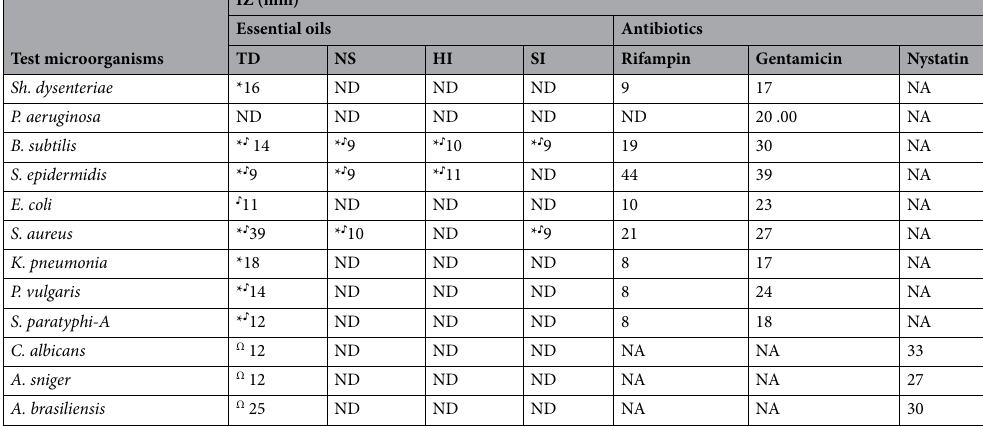
Table 2. Inhibition-zone diameters provided by antibiotics (used as references) and the essential oils from Thymus daenensis (TD), Nepeta sessilifolia (NS), Hymenocrater incanus (HI), and Stachys inflata (SI) . Mean values ± standard deviations of three cultures were reported. NA no activity, ND not determined. Symbols (*) indicate values statistically different from rifampin, symbols ( ♪ ) indicate values statistically different from gentamicin and symbols (Ω) indicate values statistically different from nystatin (p < 0.05).